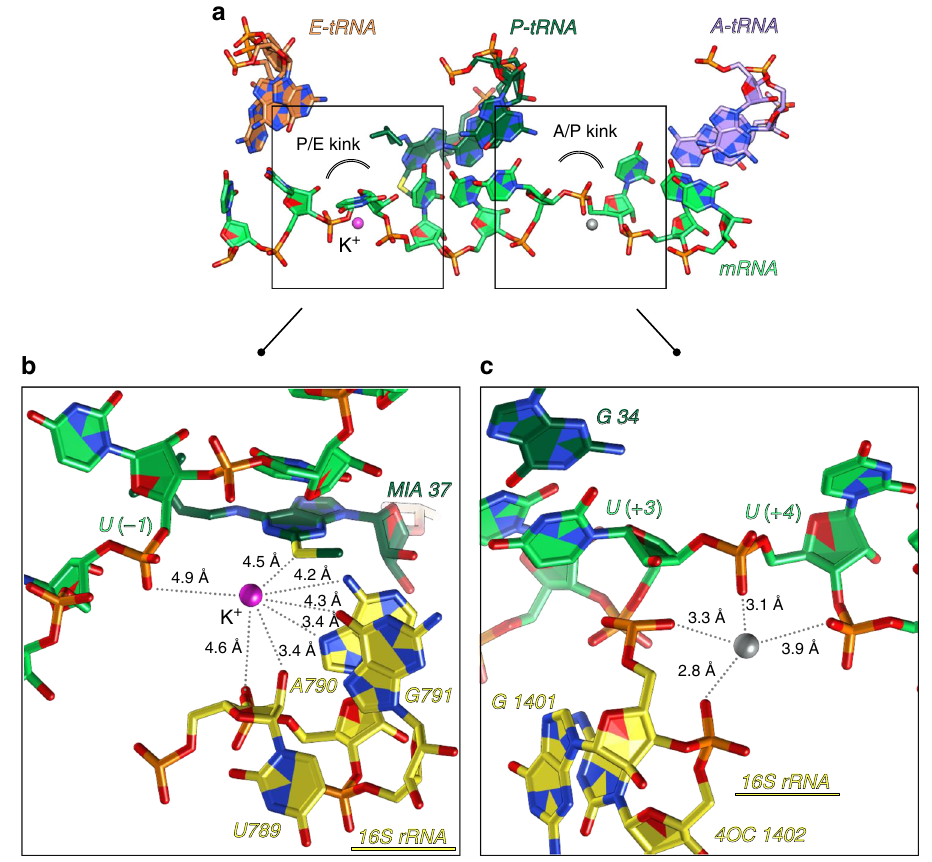
Fig. 3 Metal ions in the mRNA path in elongation complex. a Along its path in the ribosome, mRNA gets distorted between A- and P- sites (A/P kink) and between P- and E-sites (P/E kink). Together with 16S rRNA nucleotides, these distortions represent negatively charged pockets, favorable for occupation by metal ions like K + or Mg 2 + . b A K + ion was identi fi ed in the P/E kink of the elongation complex. According to the distances, this K + ion is most probably hydrated and may interact with 2-methylthio-N6-isopentenyladenosine (MIA) modi fi cation in the P-tRNA Phe and U(-1) in mRNA. c The cation identi fi ed in A/P kink was assigned as Mg 2 + in the elongation complex, however, we include the possibility that it can be a different ion (probably an ammonium ion). Color code: colors are as in Fig. 2 with unidenti fi ed ion shown in